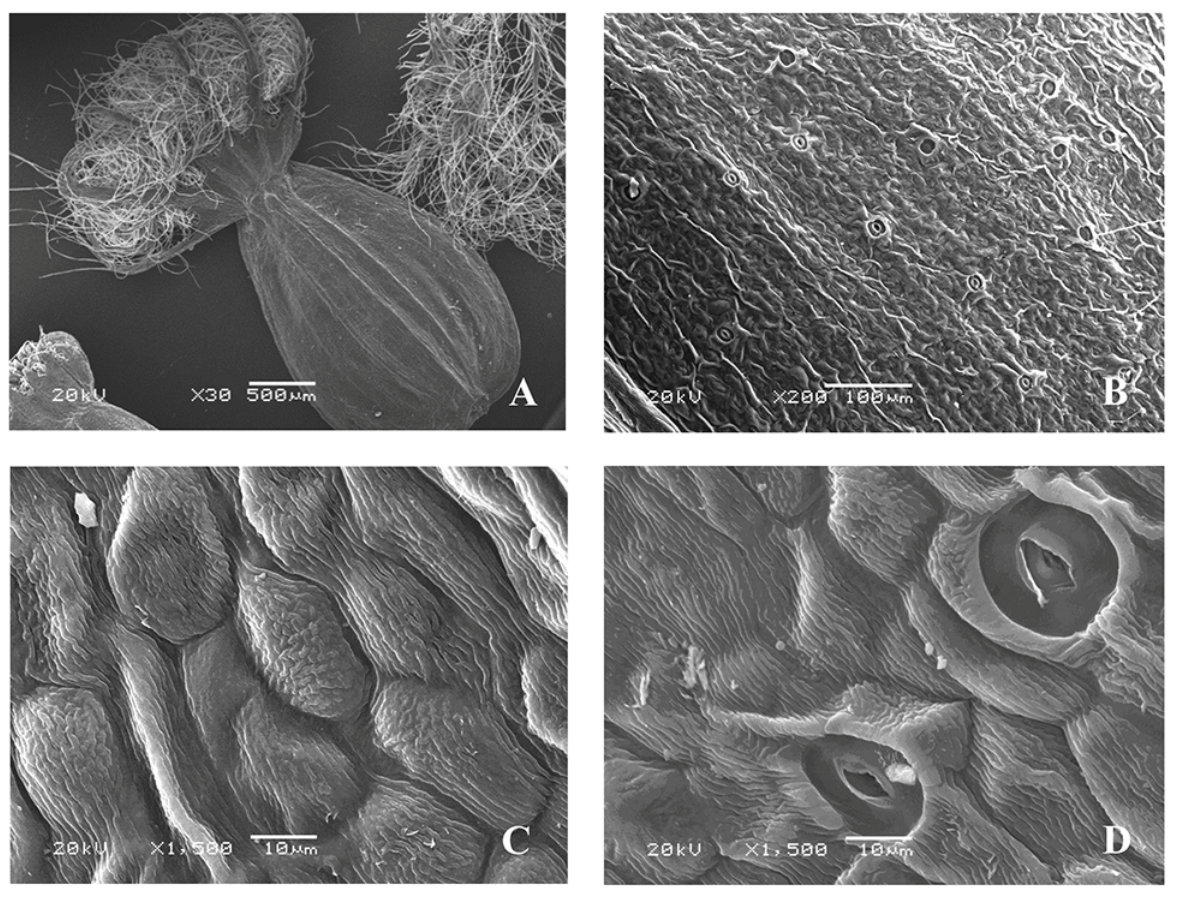
Figure 3 Fruit of Valeriana simplicifolia (SEM): General view ( A ); fragments of the fruit surface ( B,C ); stomium ( D ).